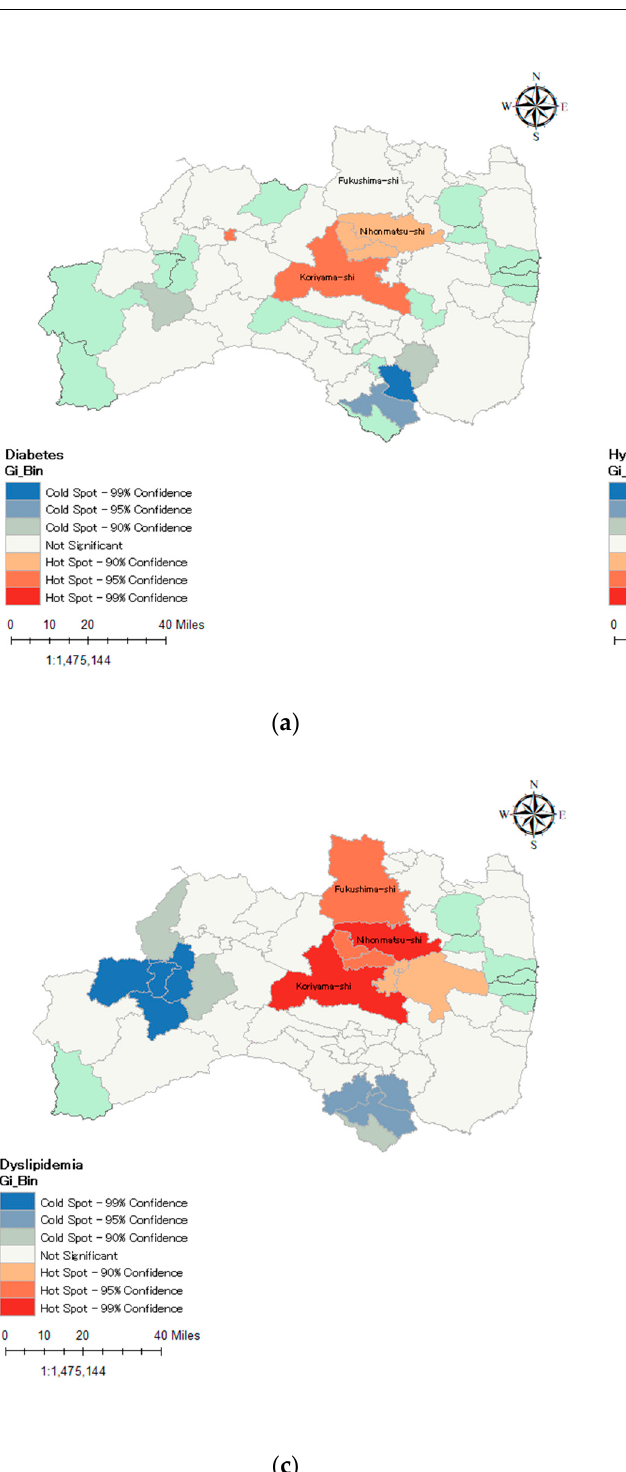
Figure 3. Hot spot analysis of spatial prevalence of lifestyle-related diseases among survey partici- pants: ( a ) Spatial pattern of diabetes; ( b ) Spatial pattern of hypertension; ( c ) Spatial pattern of dyslipidemia.